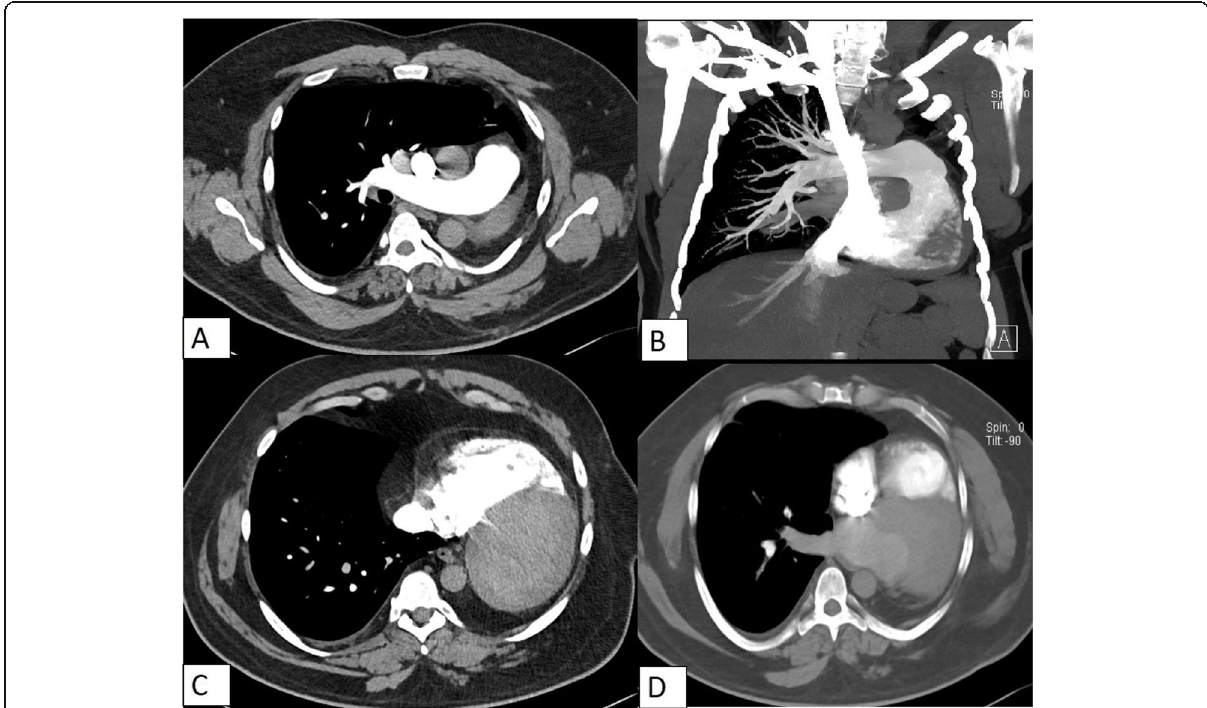
Fig. 3 CT pulmonary angiogram showing continuation of patent main pulmonary artery into right pulmonary artery with absent left pulmonary artery ( A , B ). The heart is shifted into left hemithorax, lying flush with the chest wall with increased pericardial fat ( C , D